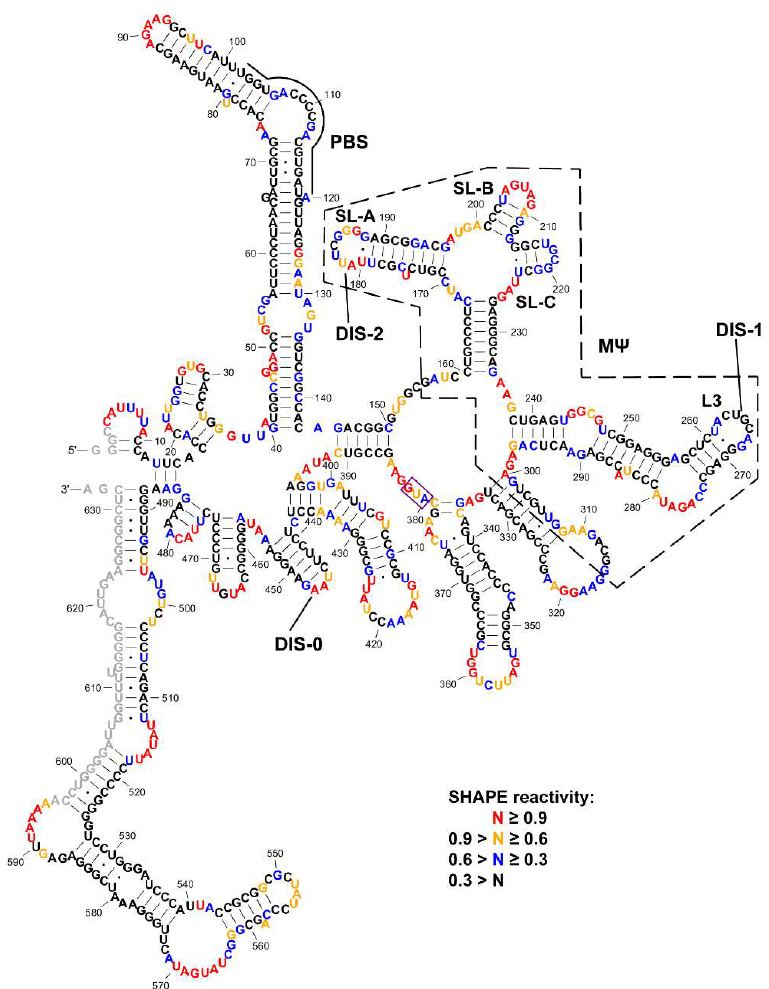
Figure 1. Selective 2’-hydroxyl acylation analyzed by primer extension (SHAPE) reactivity- constrained lowest energy secondary structure of the 636-nt Rous sarcoma virus (RSV) 5’-leader RNA. The secondary structure model was generated by applying averaged normalized SHAPE reactivity from three independent trials as pseudo free-energy constraints in RNAstructure [53] . Nucleotides are colored in accordance to SHAPE reactivity as indicated in the key. Nucleotides that could not be analyzed due to primer annealing (3’ end) or the lack of resolution (5’ end) are shown in grey. MΨ is indicated by a black dashed box. Stem loops in µΨ and loops that were tested in the dimerization assays (DIS-0, DIS-1/L3, DIS-2/SL-A, SL-B and SL-C) are labeled. The AUG start codon is indicated by a purple box.